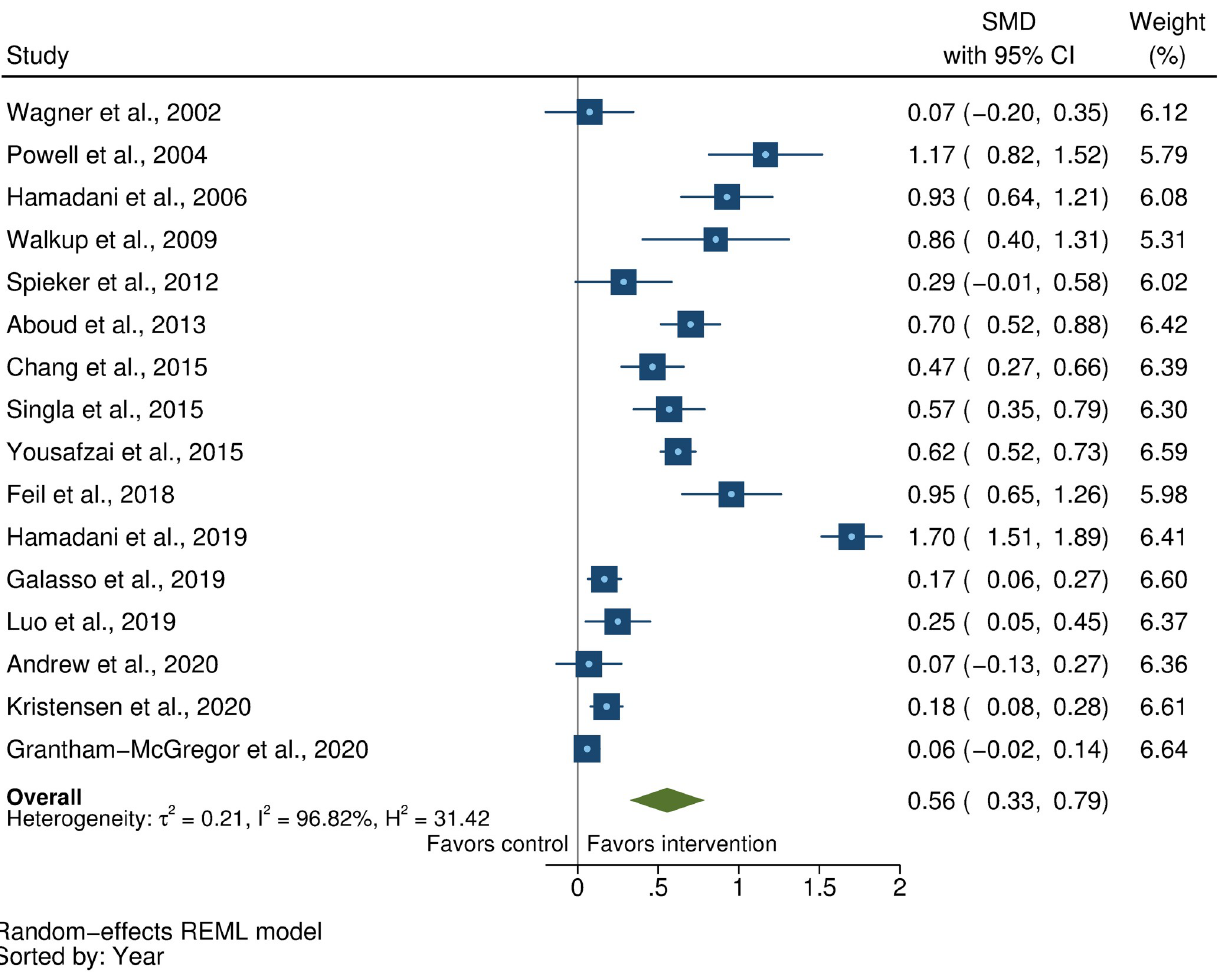
Table 2). Although effects on child socioemotional development, parenting knowledge, parent